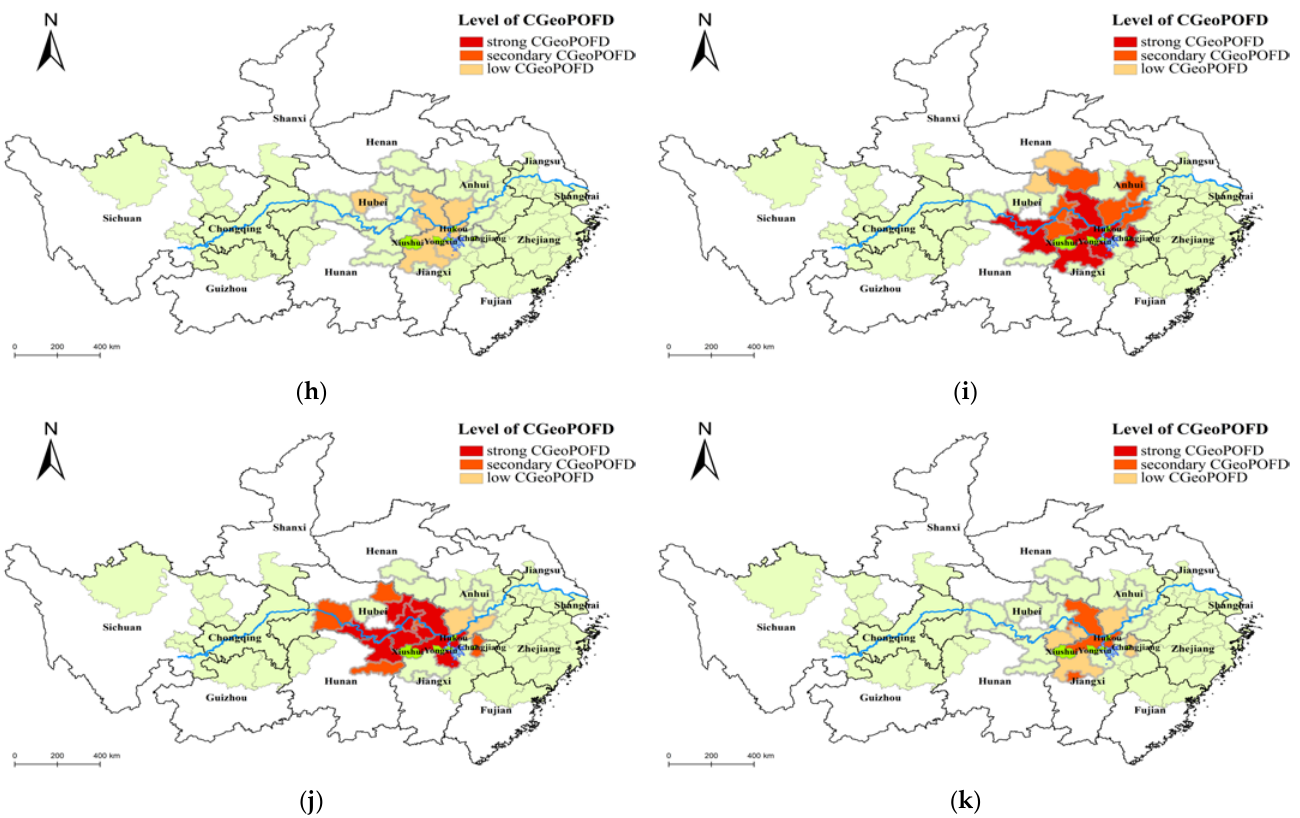
Figure 6. The temporal and spatial evolution of CGeoPOFDs. The first stage is shown in ( a , b ). The second stage is depicted in ( c – g ). The third stage includes ( h – k ).